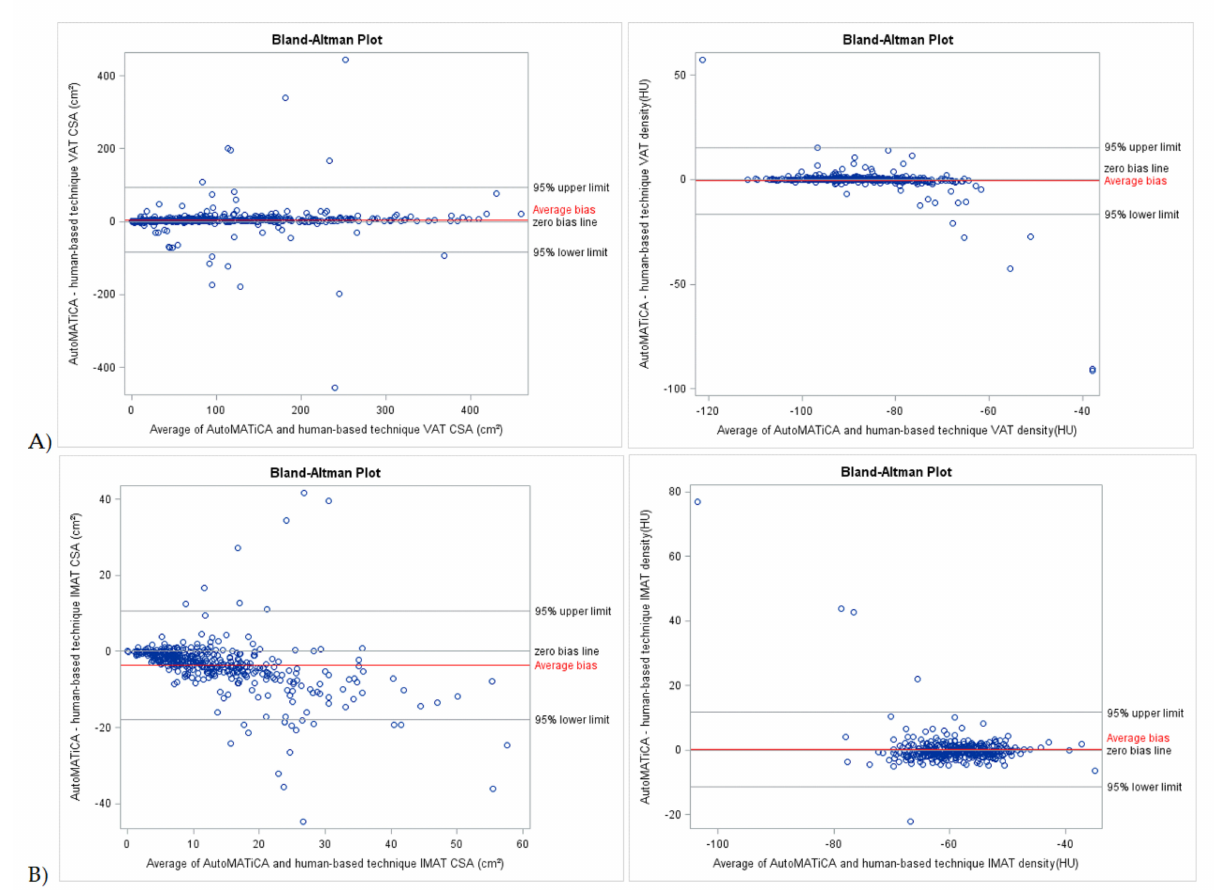
Figure 3. Bland-Altman plots of body composition parameters between test (AutoMATica) and reference (SliceOmatic plus ABACS + manual correction) method for entire sample. Plots show cross-sectional area (CSA) and density visceral adipose tissue (VAT, A ), and intermuscular adipose tissue (IMAT, B ). Limits of agreement within 1.96 standard deviations are shown with average bias (red line) for each